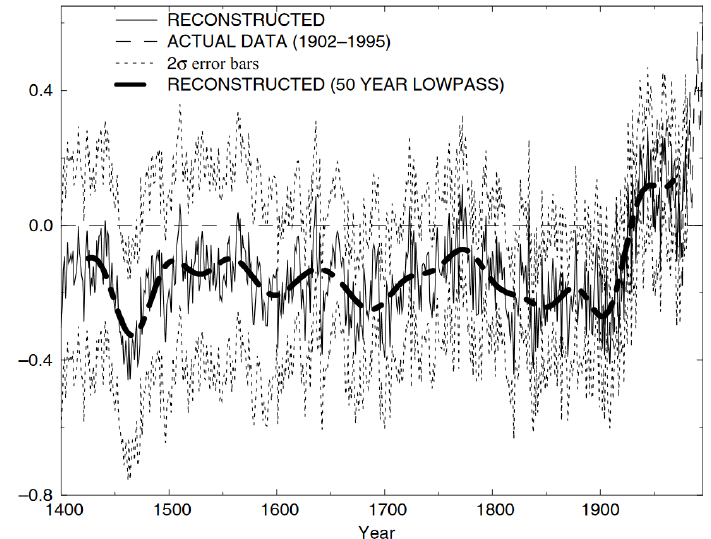
Figure 1. The ‘hockey stick graph’: a millennial reconstruction of average temperatures in the northern hemisphere from Mann et al. (1999).